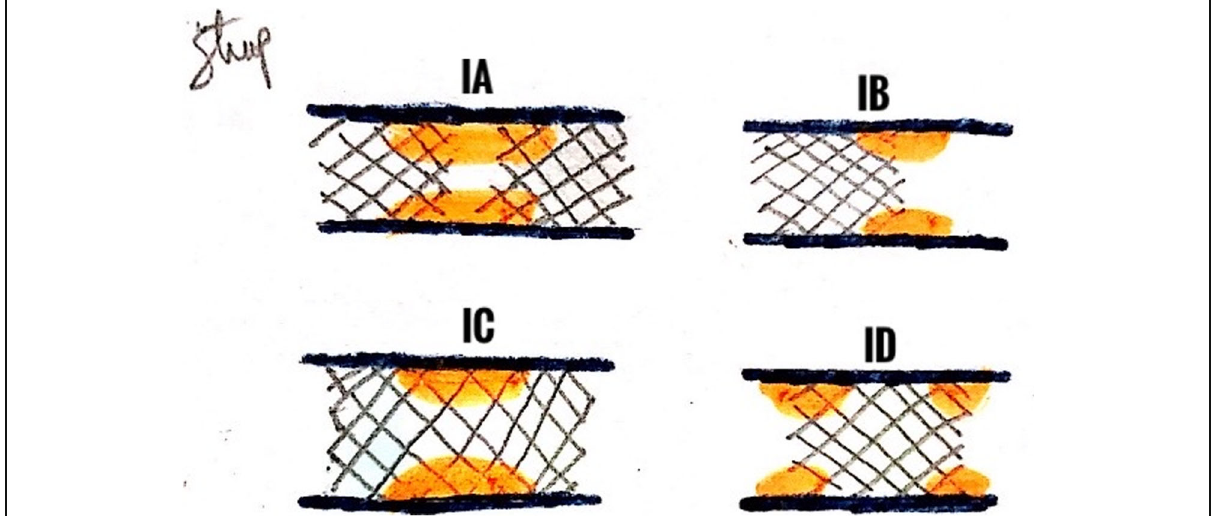
Fig. 1 Focal ISR classification according to angiographic classification. IA Articulation or gap. IB Margin. IC Unifocal. ID